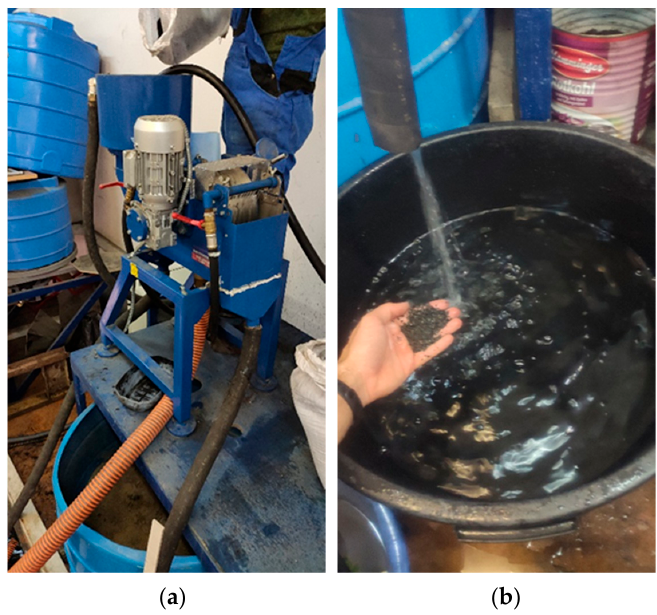
Figure 12. Magnetic separator ( a ), and obtained material ( b ). At the same time, in the first stage, the separator acts on the coal ash with a magnetic induction of 600 T, removing various contaminants together with iron-containing parti- cles; at the next stage, a more precise cleaning with a magnetic induction of 400 T takes place. Table 3 lists the chemical composition of the iron-containing component after each magnetic separation stage.